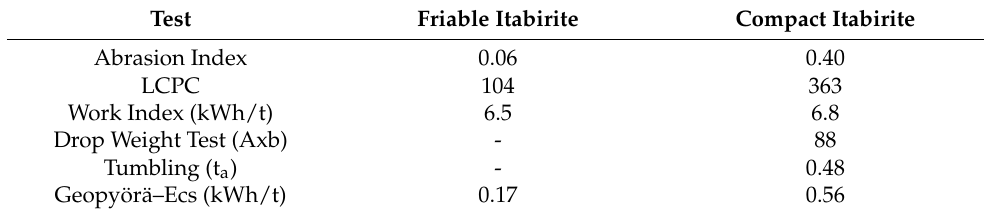
Table 4. Sample characterization results.